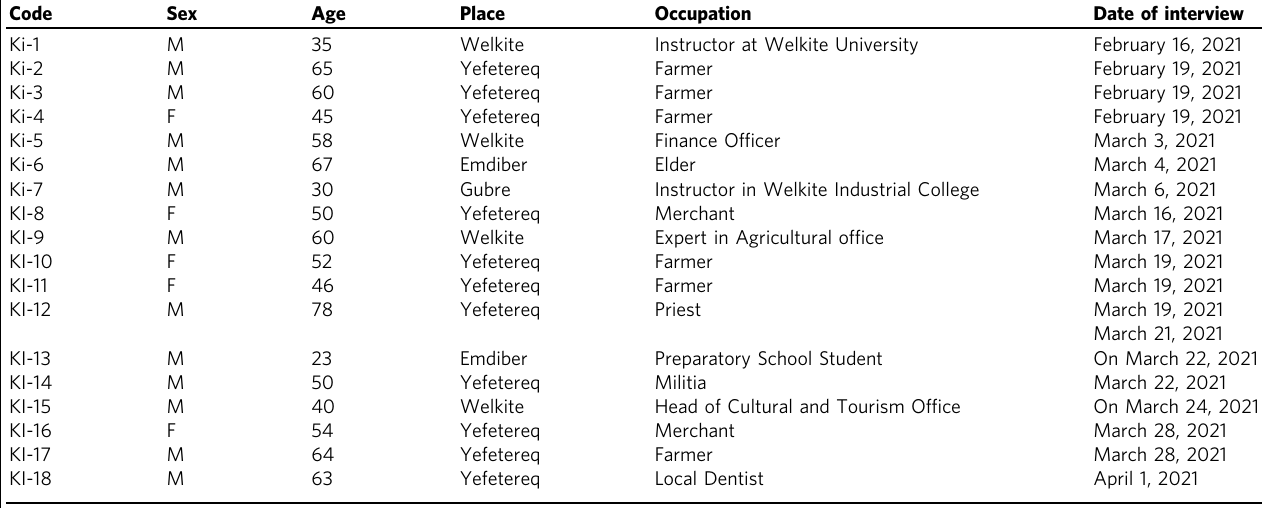
Table 1 Pro fi le of the key informants or participants of the